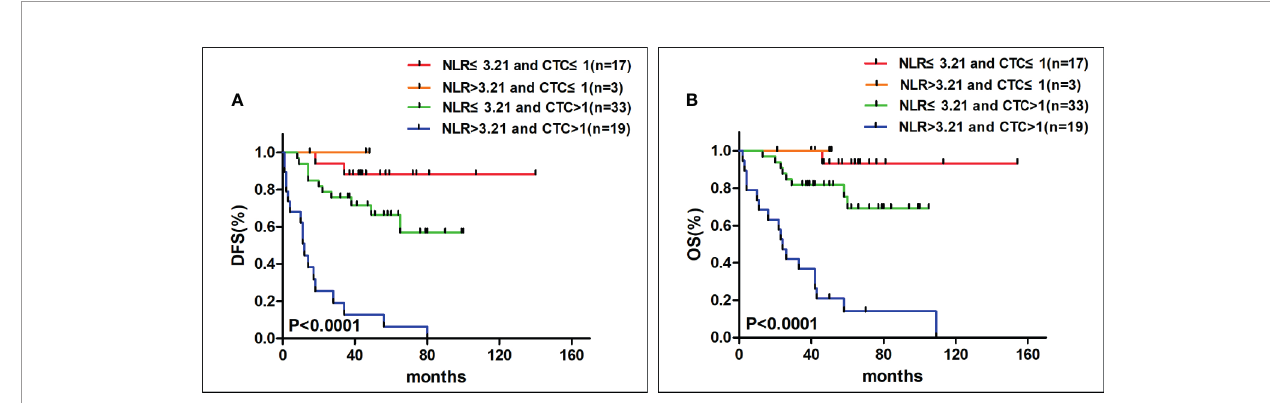
FIGURE 2 | The Kaplan – Meier analysis curves on DFS (A) and OS (B) when associating NLR and CTCs counts (DFS, disease-free survival; OS, overall survival; NLR, neutrophil – lymphocyte ratio; CTCs, circulating tumor cells). In patients with higher NLR and higher CTCs counts had shorter DFS and